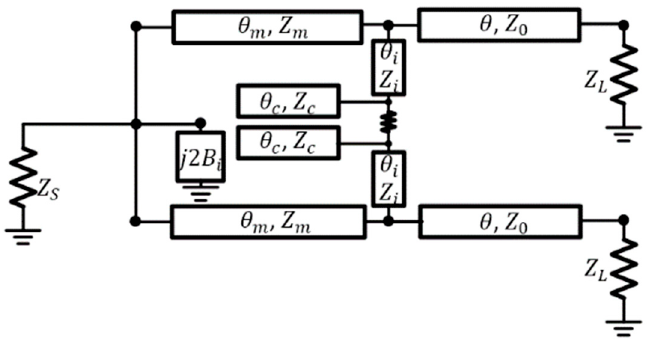
Figure 1. The configuration of the proposed power divider with coupled-line section adopted in the complex isolation network.